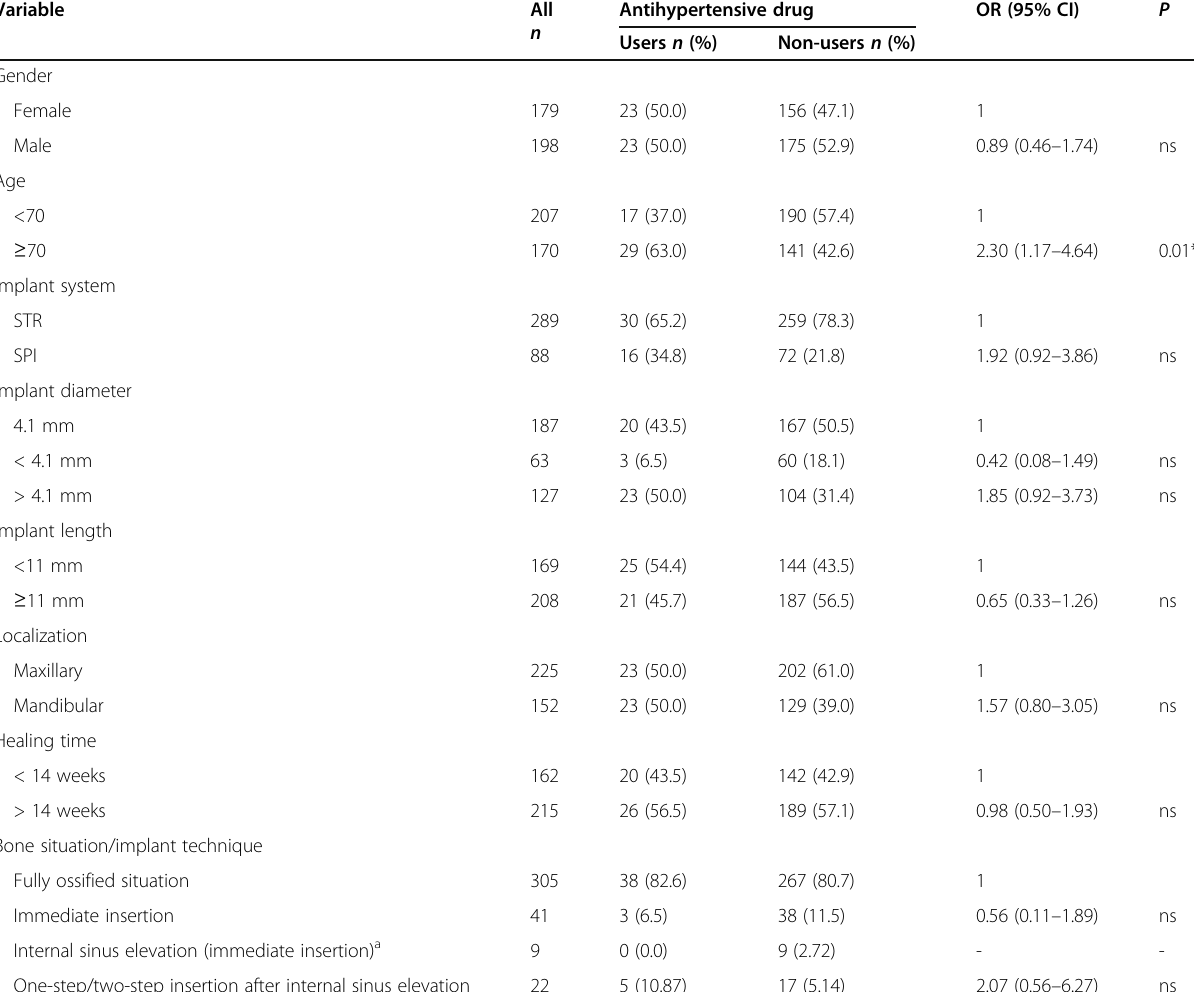
Table 1 Comparison of antihypertensive drug users and non-users by implants ( n =377)